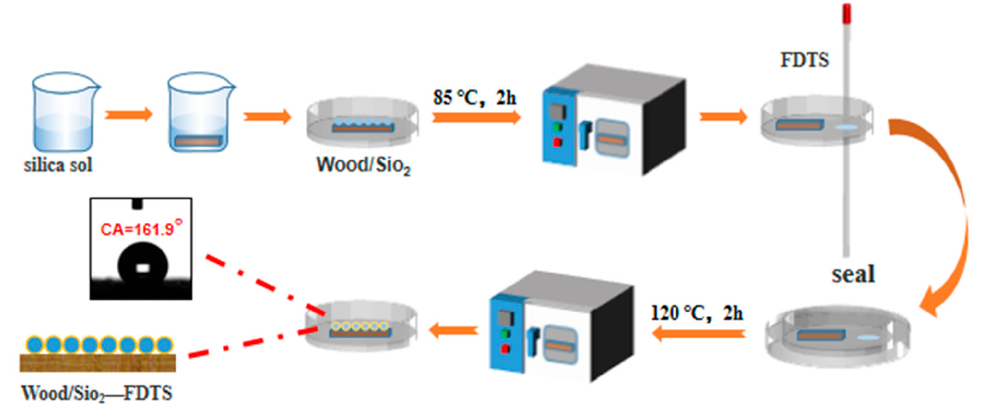
Figure 1. Preparation process of superhydrophobic wood. Table 1. Serial numbers of wood before and after modi fi cation.